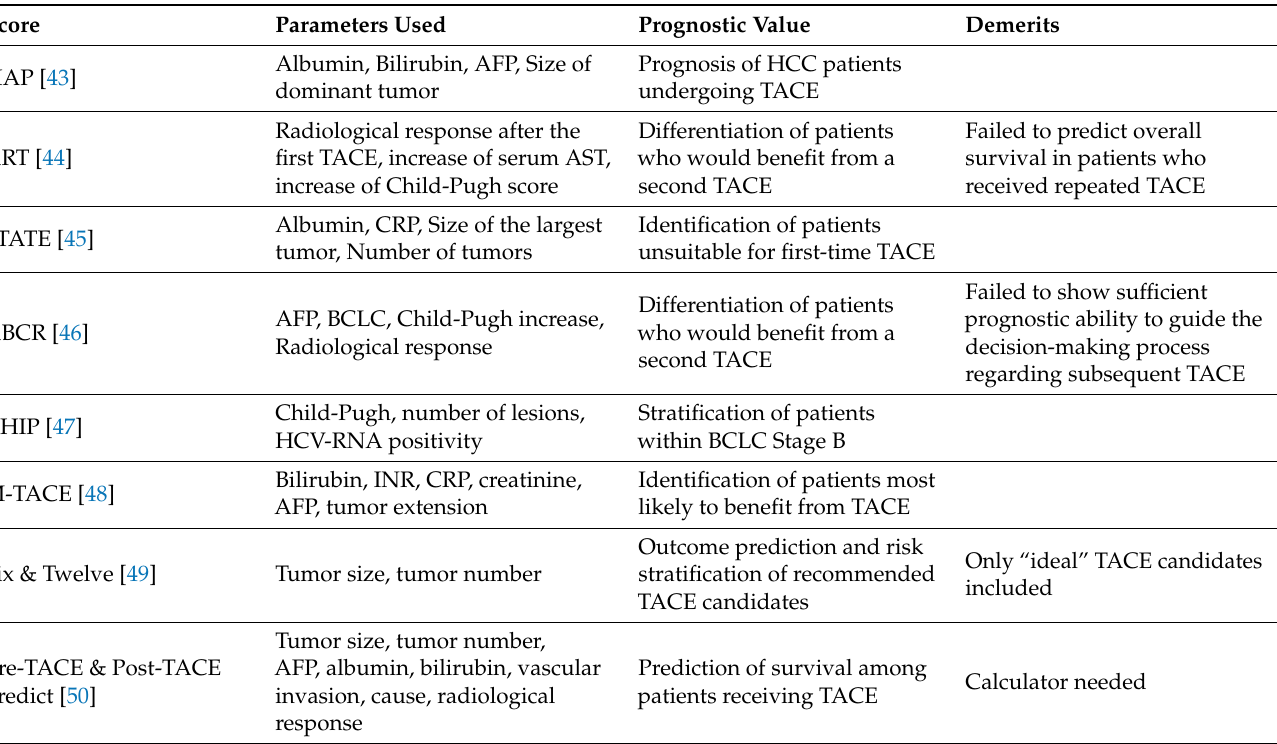
Table 1. Prognostic scores. AFP: alpha-fetoprotein, TACE: transarterial chemoembolization, AST: aspartate protein, BCLC: Barcelona Clinic Liver Classification, HCC: Hepatocellular